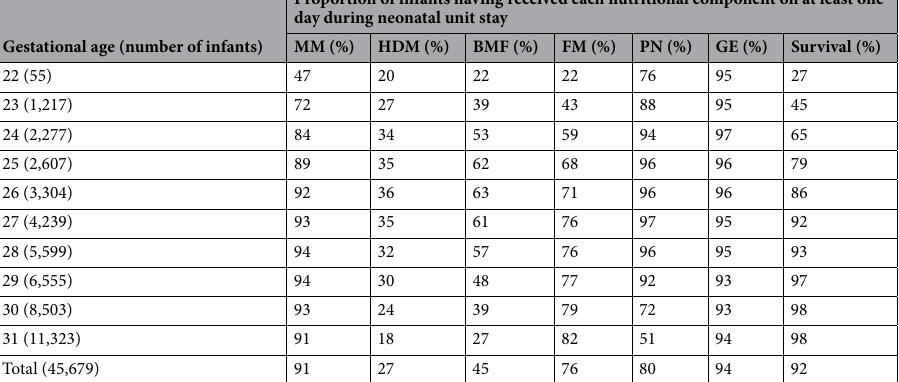
Table 1. Receipt of each nutritional component stratified by gestational age. Proportions of infants who received each component on at least one day are reported along with survival rates. Components are abbreviated as MM: Maternal milk, HDM: Human Donor Milk, BMF: Breast Milk Fortifier, FM: Formula Milk, PN: Parenteral Nutrition, GE: Glucose Electrolyte solution.